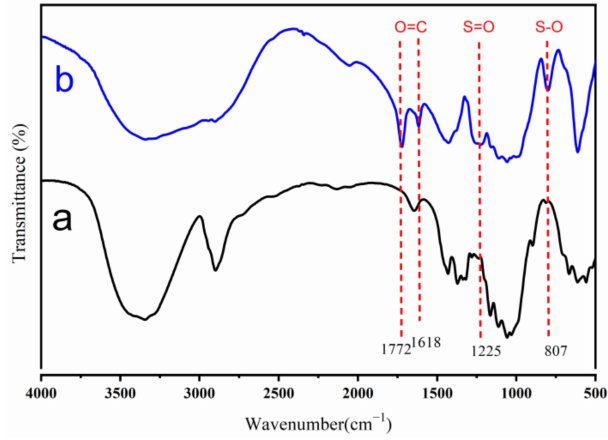
Figure 1. FT-IR spectra of (a) cotton linters cellulose (b)